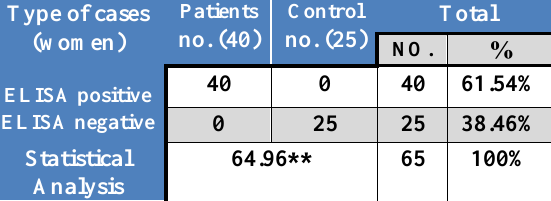
Significant differences (P≤